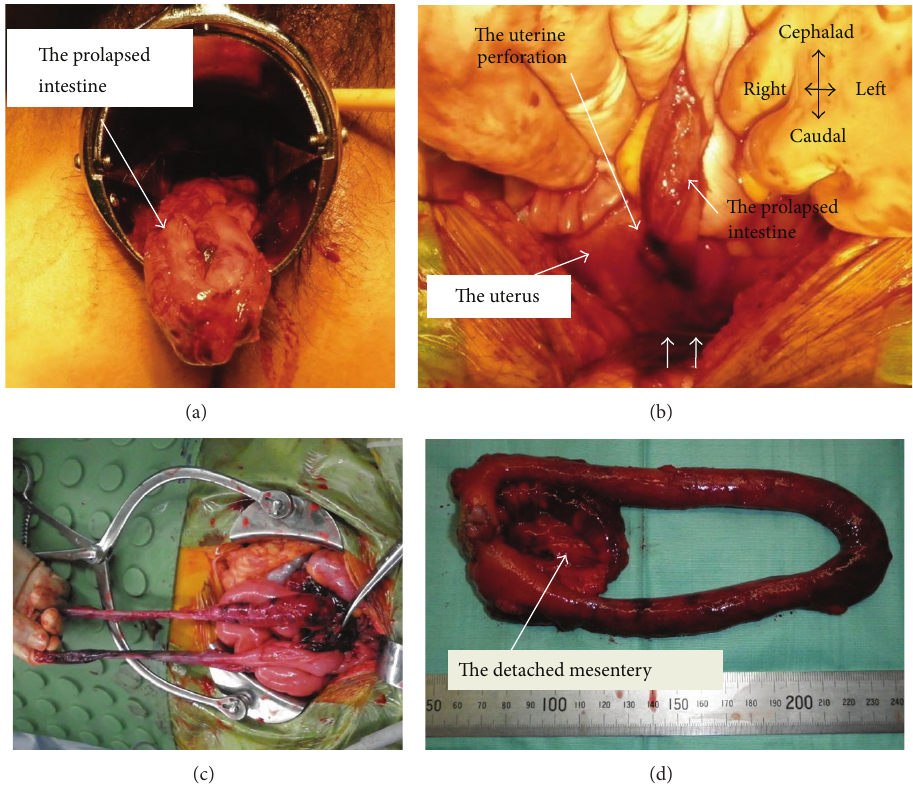
Figure1: Prolapsed smallintestineand operativefindings. (a)Thesmall intestineisobserved in thevagina. (b)Theileum isprolapsed through the uterine perforation and somewhat retracted. The uterine fundus is not seen, hidden behind the operators’ hands. Small arrows show the previous cesarean scar site, indicating that the perforation did not occur at the previous cesarean incision. The direction of the perforation is not distinguishable in this figure: it is illustrated in Figure 2. (c) The prolapsed intestine is necrotic. The tip of the forceps indicates the detached mesentery. (d) The resected specimen, showing that the mesentery (50cm) was completely separated from the prolapsed ileum.